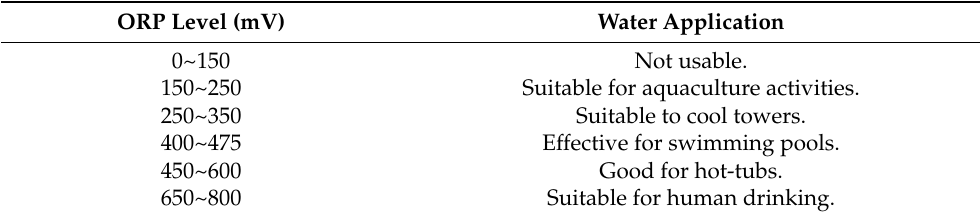
Table 7. ORP-ranges versus water applications